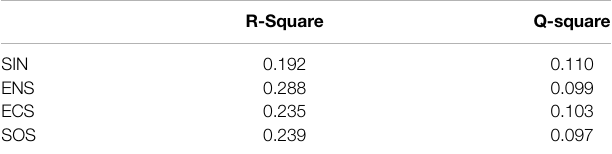
TABLE 7 | Predictive power of